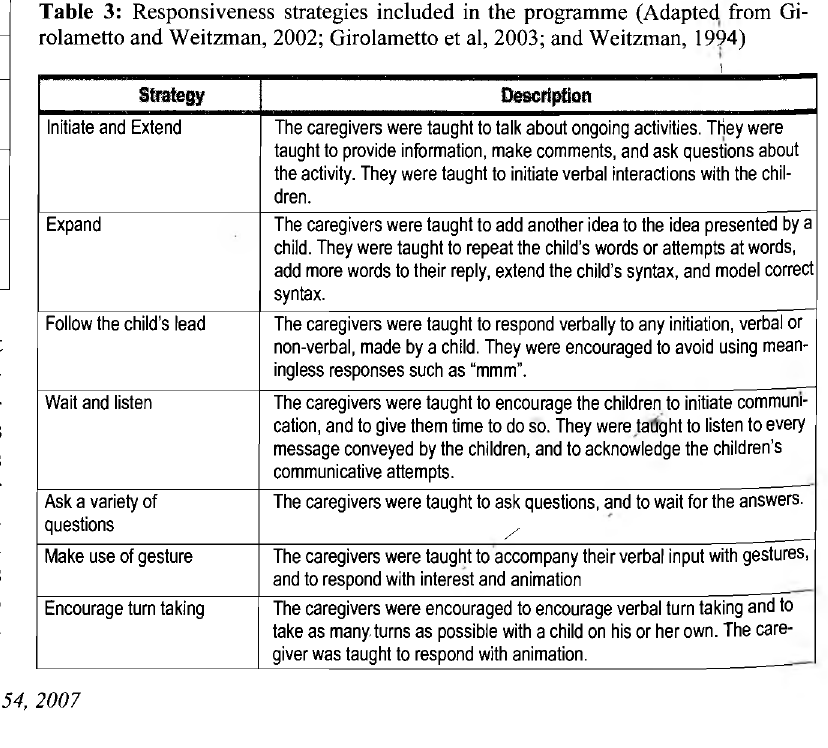
Table 2: Checklist CDS behaviours